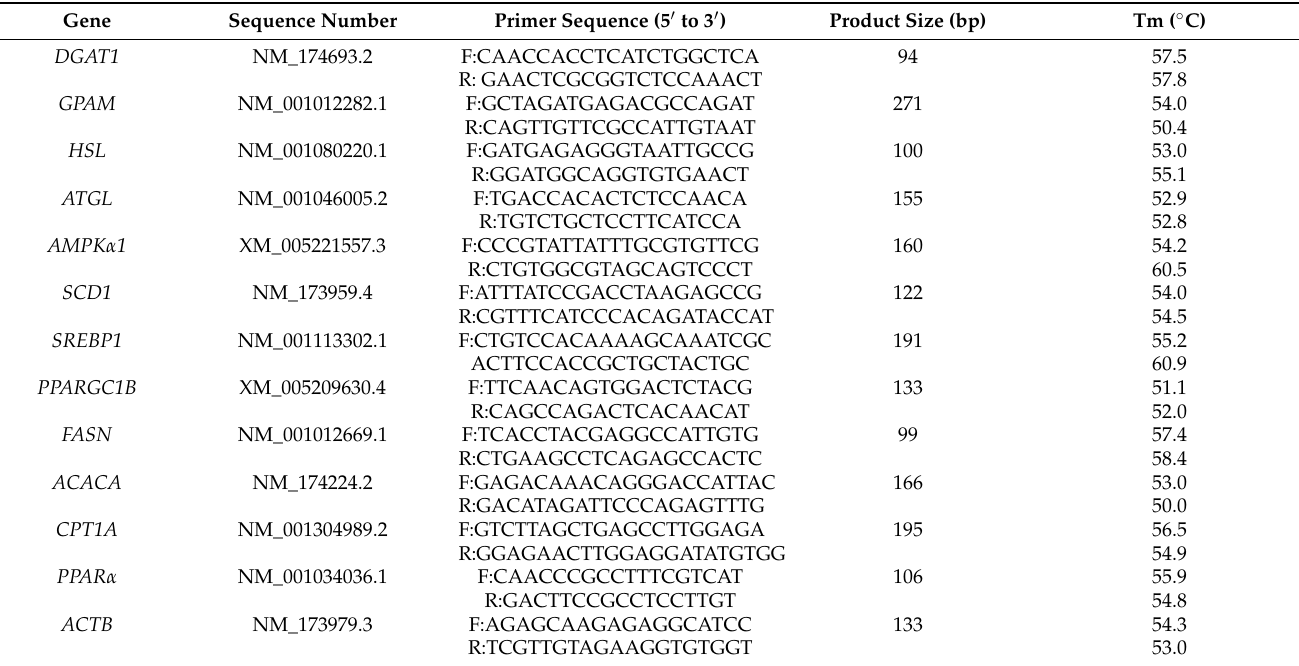
Table A1. Primer sequences used for quantitative real-time PCR 1